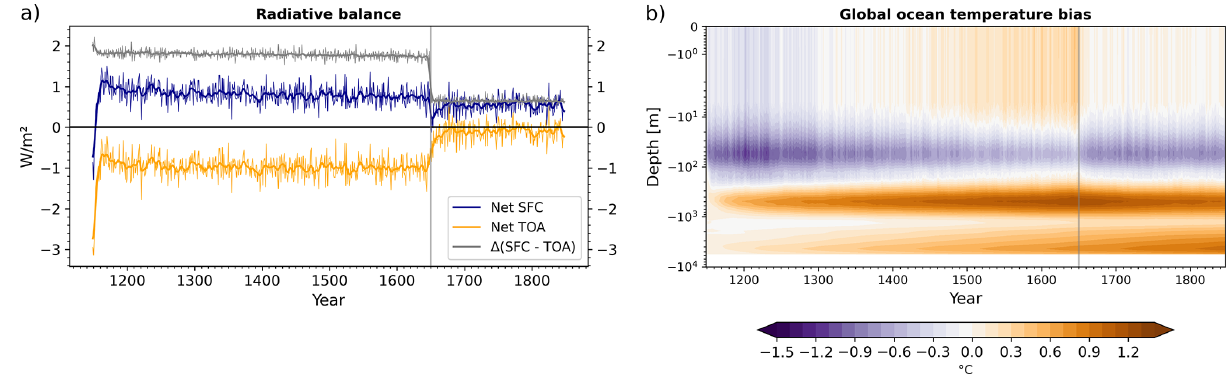
Figure 3. (a) Net radiative imbalance at the top-of-atmosphere (TOA) and at the surface (SFC) in the spinup simulation. Positive (negative) values indicate downward (upward) net heat flux. The difference results from spurious energy production in the atmosphere. (b) Semi- logarithmic depth Hovmöller diagram of the evolution of the global-mean ocean temperature bias over the spinup period with respect to PHC3 climatological values (Steele et al., 2001). Switching from the dry to total mass fixer after 500 years reduced spurious heat production in the atmosphere and halted the ocean warming trend in the upper 1000m. Warming at depth